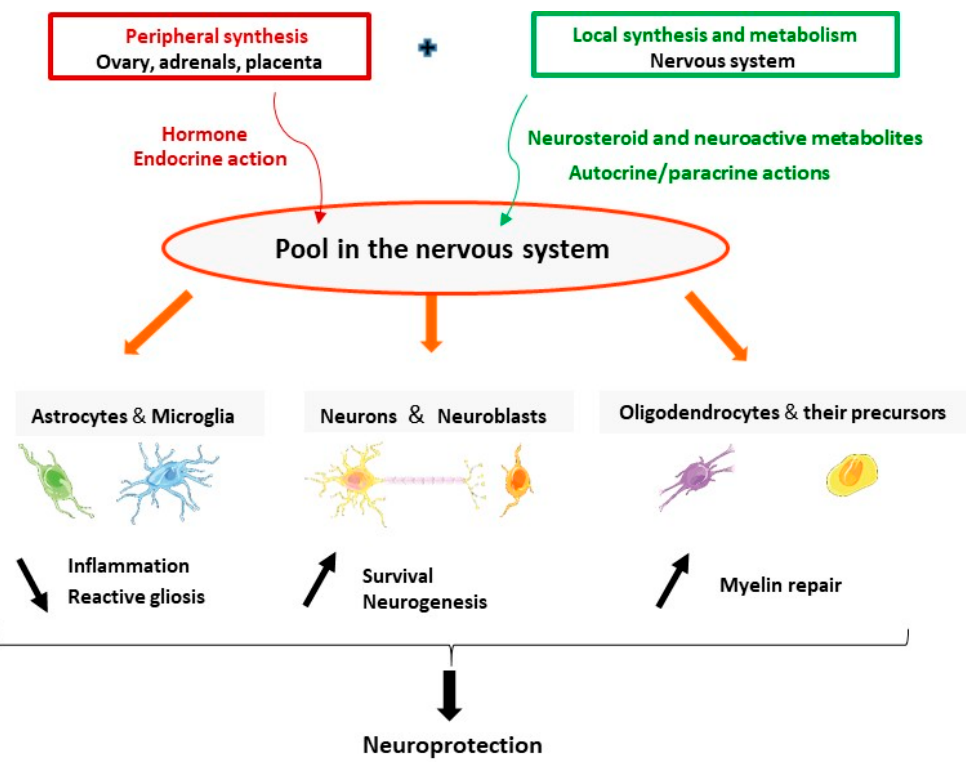
Figure 2. The brain is a site of synthesis, metabolism, and action of progesterone. Progesterone (either synthesized in the endocrine glands or locally in the nervous system) and its neuroactive metabolites have pleiotropic neuroprotective effects. They act in astrocytes and microglia to reduce inflammation and reactive gliosis; promote survival of neurons and neurogenesis; and increase myelination by acting in oligodendrocytes and their precursors.